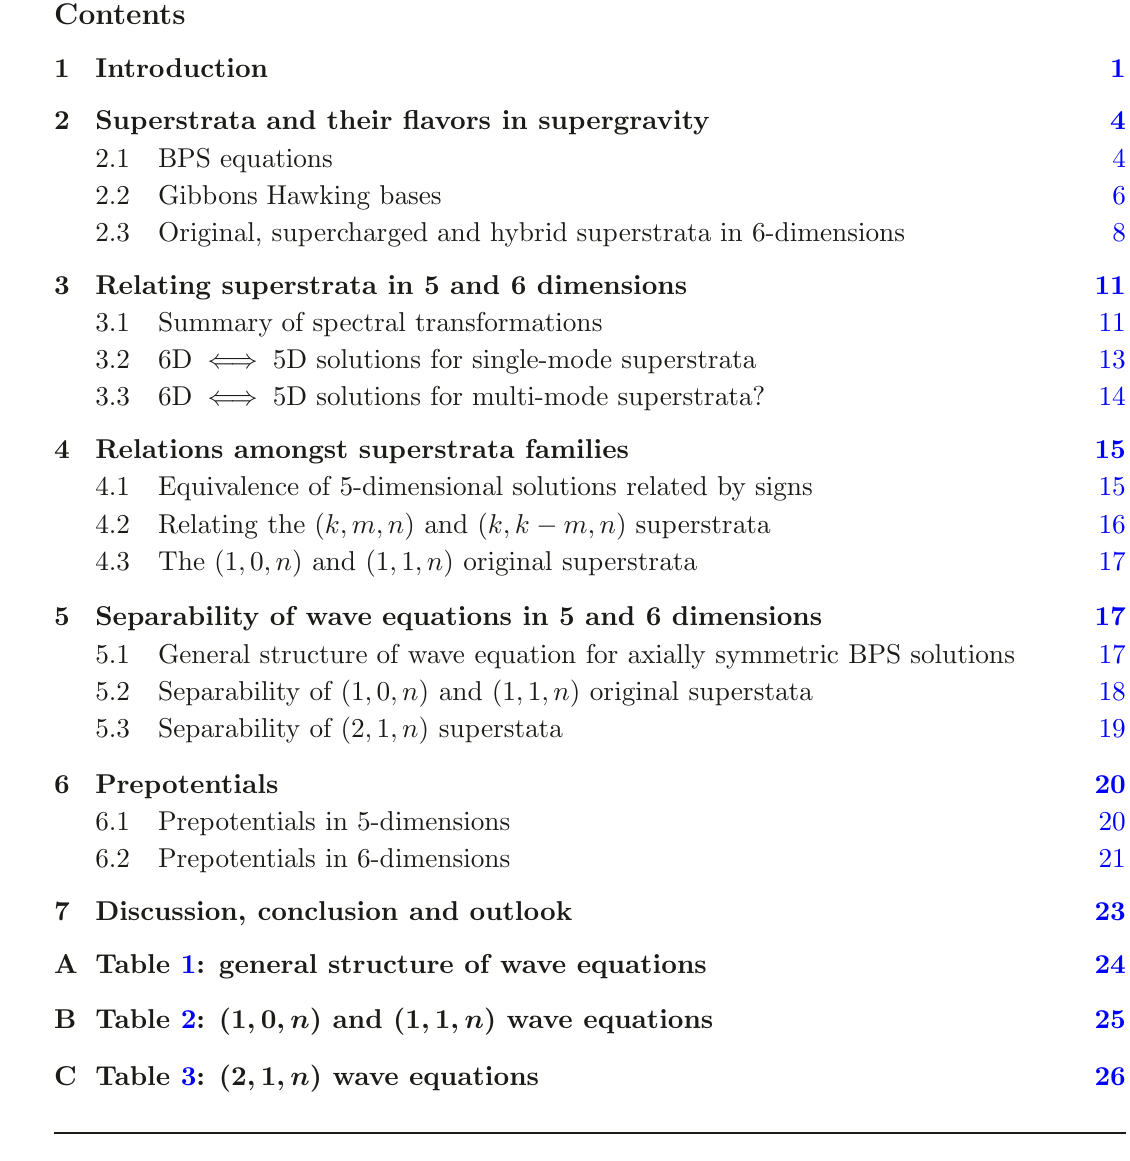
A Table 1: general structure of wave equations 24 B Table 2: (1 , 0 , n ) and (1 , 1 , n ) wave equations 25 C Table 3: (2 , 1 , n ) wave equations